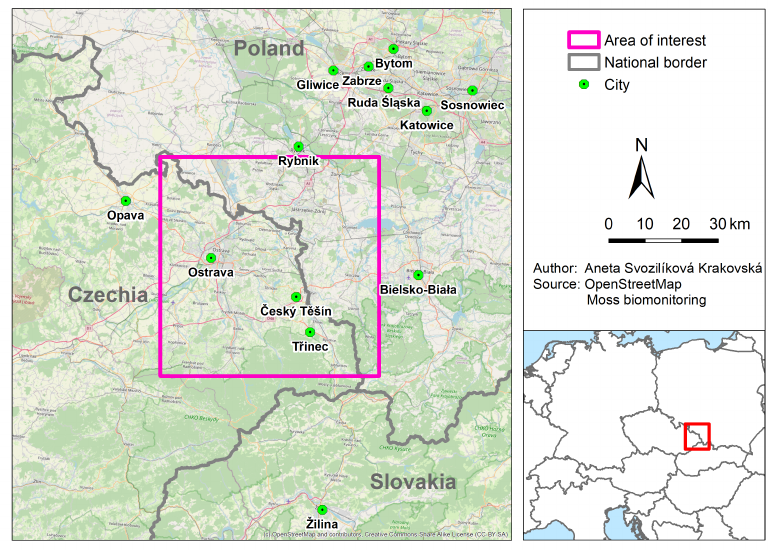
Figure 3. Map of sampling